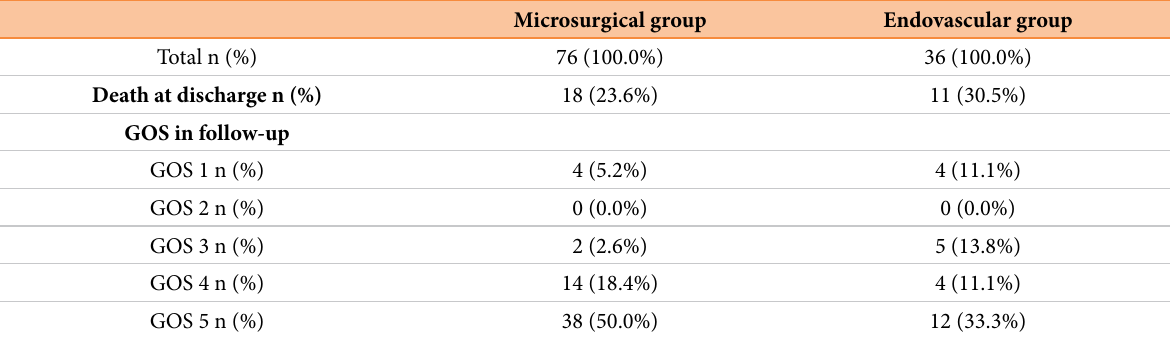
Table 5 - Short and long-term